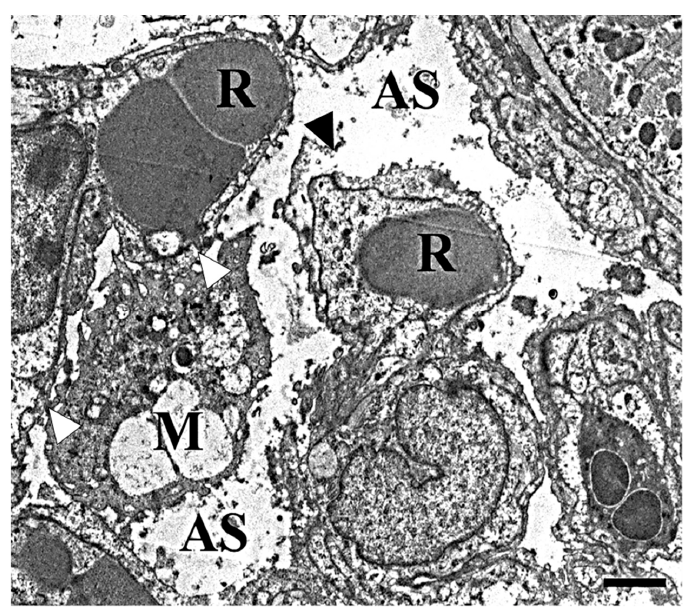
Figure 8. Transmission electron microscopic images of the inflammatory lesions in the lung from mice treated with 50 mg/m 3 of the powder for three days. Destruction of the alveolar walls (black arrowhead) with epithelial cells showing vacuolar degeneration was observed in the inflammatory lesions. Note that the macrophage containing the particles is closely located to the alveolar wall (white arrowheads). AS: alveolar space, R: red blood cell, M: macrophage. Bar = 1 µm.